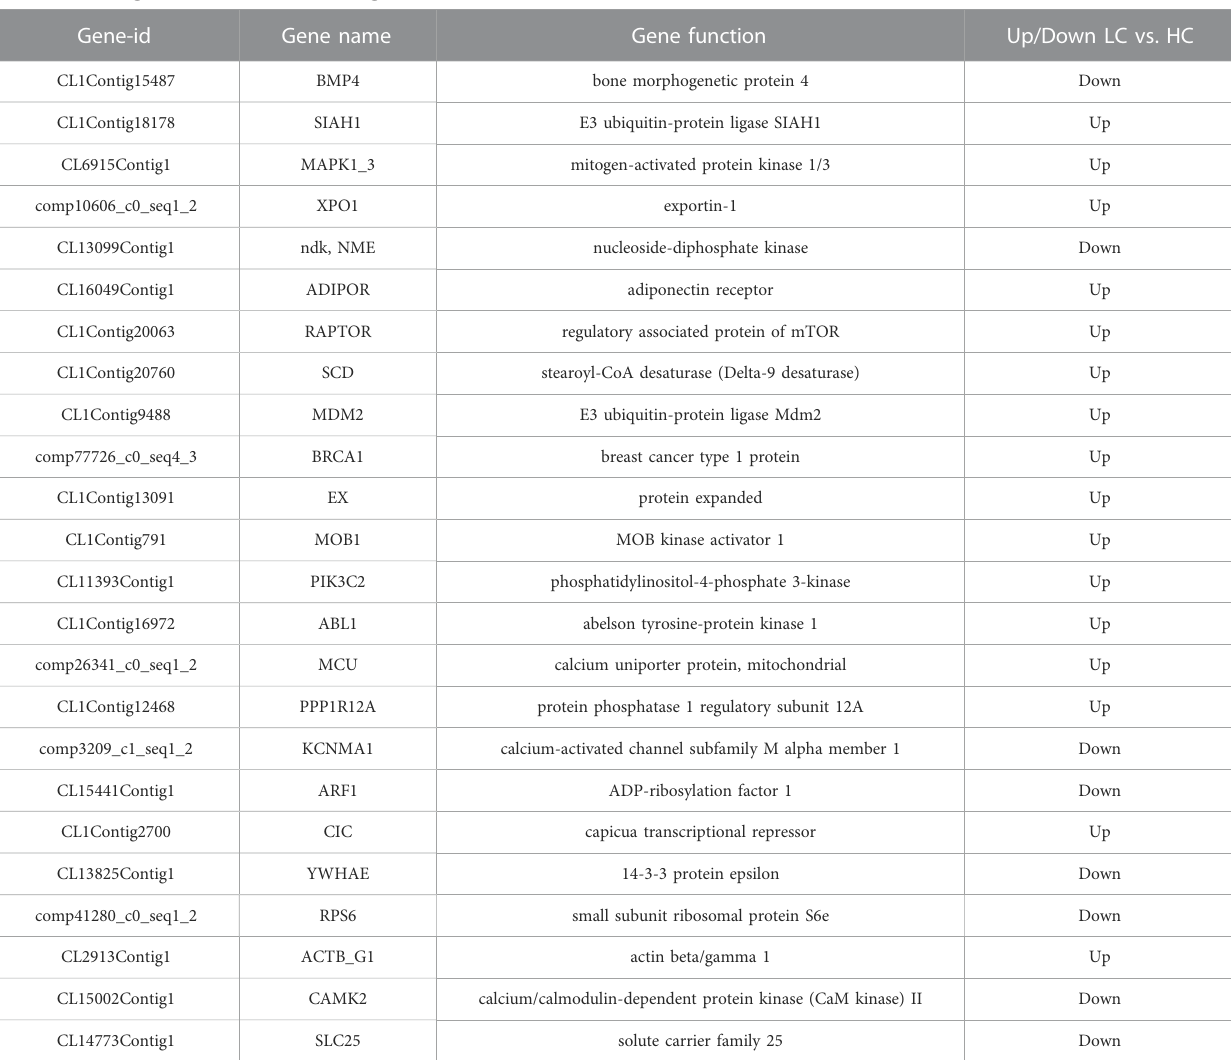
TABLE 5 Partial signal transduction differential genes. Gene-id Gene name Gene function Up/Down LC vs.